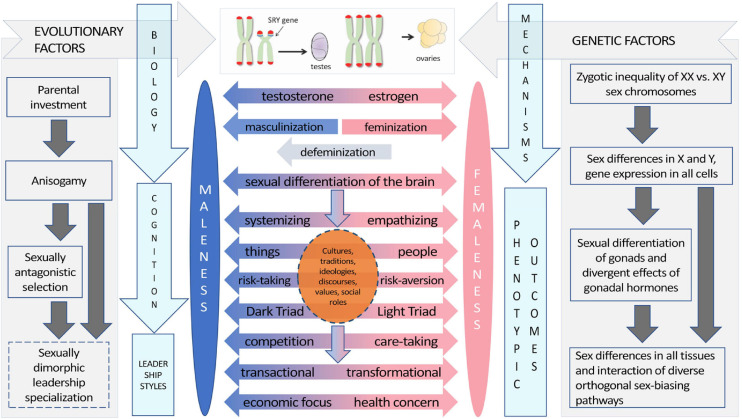
The evolutionary–developmental origins and proximate mechanisms underlying psychobehavioral sex differences, including those in leadership. Sexually dimorphic leadership specialization is included as a new hypothesis, not as an established fact. Figure adapted from Luoto et al. (2019a), Arnold (2020), McCarthy (2020), and Malmi (2021).